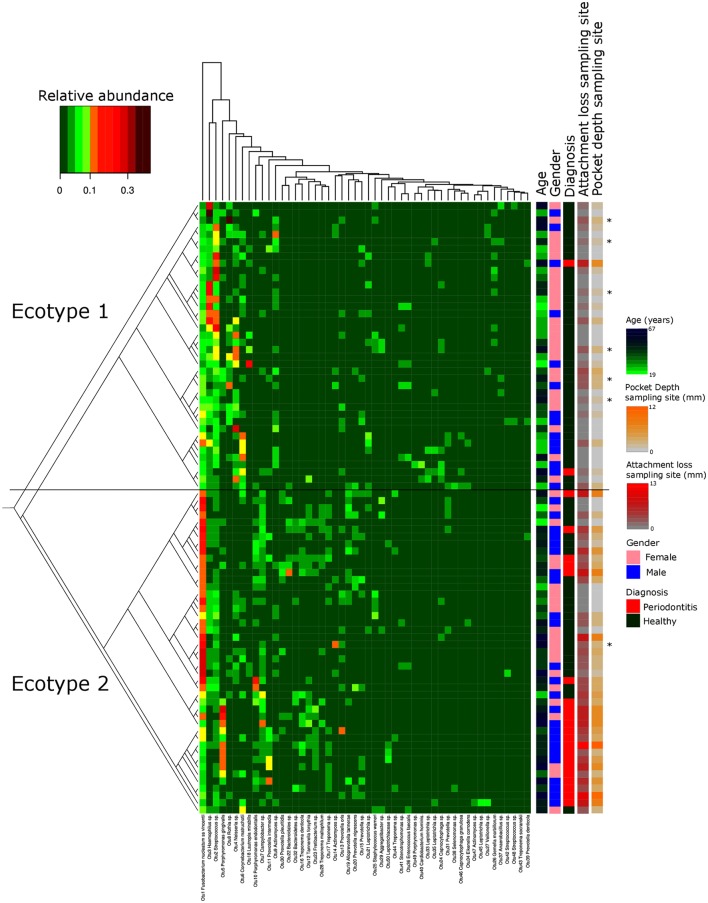
Microbiota’s structure analysis of the subgingival communities in periodontitis and correlation of microbial profiles with clinical and demographic measurements. Shown is a heatmap of the relative abundance for the top 50 OTUs found in the study cohort. Patients are in rows and OTUs are in columns. The color key is shown on the upper left. Patients are clustered based on the Bray–Curtis distance between their microbial communities validated by a k-mean algorithm probabilistic modeling (1000000 iterations). These distances are represented in the left tree showing two distinct clusters (Ecotypes 1 and 2). Relevant clinical and demographic characteristics are depicted in color codes at the right side. Patients diagnosed for periodontitis via the full mouth diagnosis but sampled at a non-diseased local site are symbolized by a ∗.